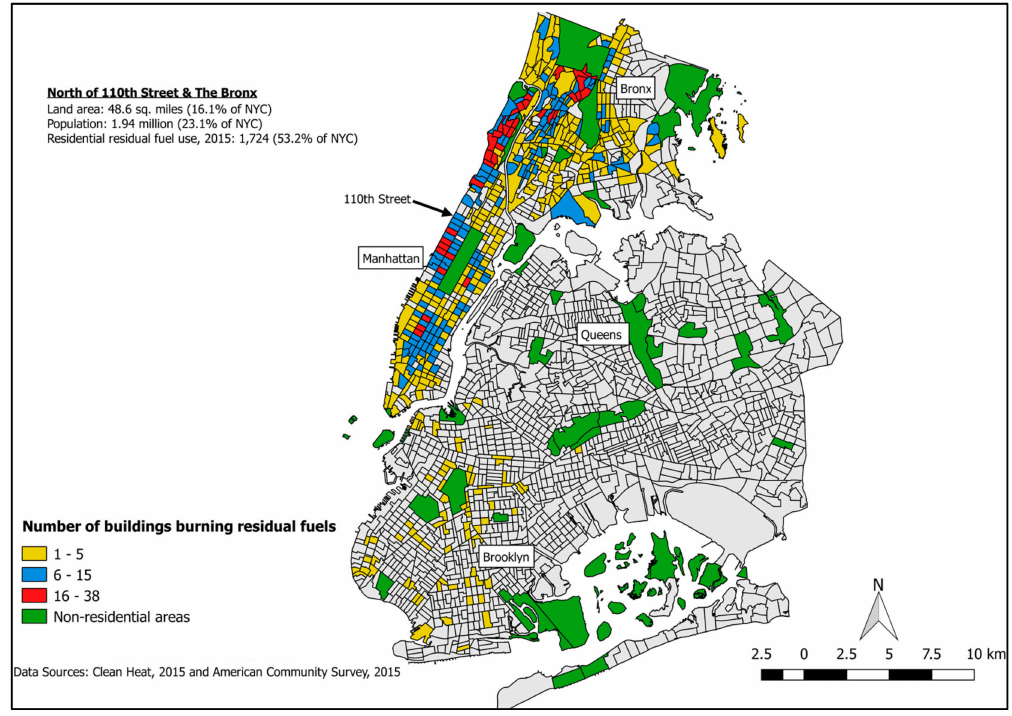
Figure 1. Remaining Residual Fuel Boilers per US Census Tract,